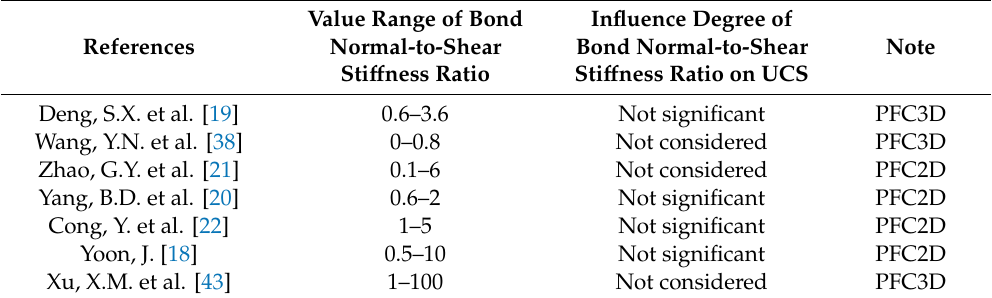
Table 1. Summary of the PFC study on the relationship between micro-parameters and